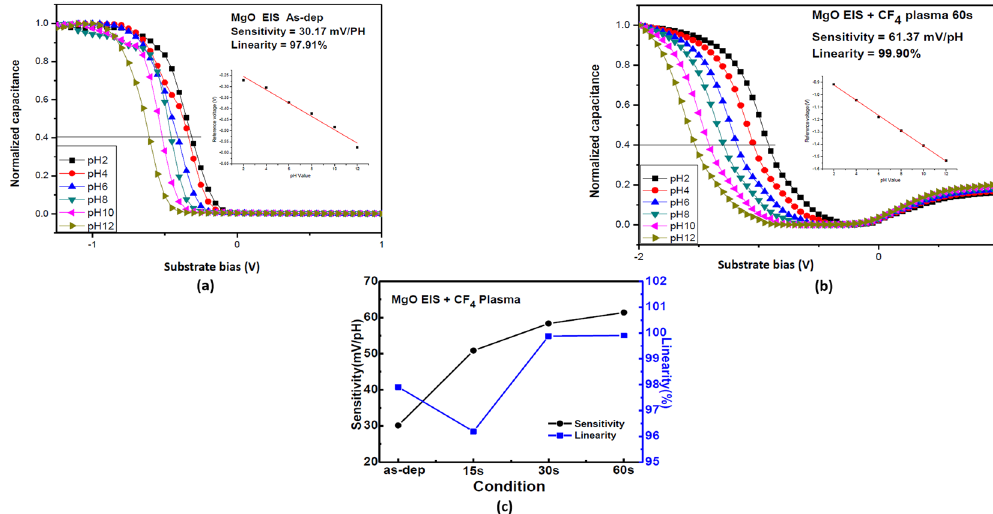
Figure 6. The normalized C-V curve of the sample ( a ) without and ( b ) with CF 4 plasma treatment for 60 sec. The inset figure represents the sensitivity and linearity. ( c ) The sensitivity and linearity of the samples with CF 4 plasma treatment in various